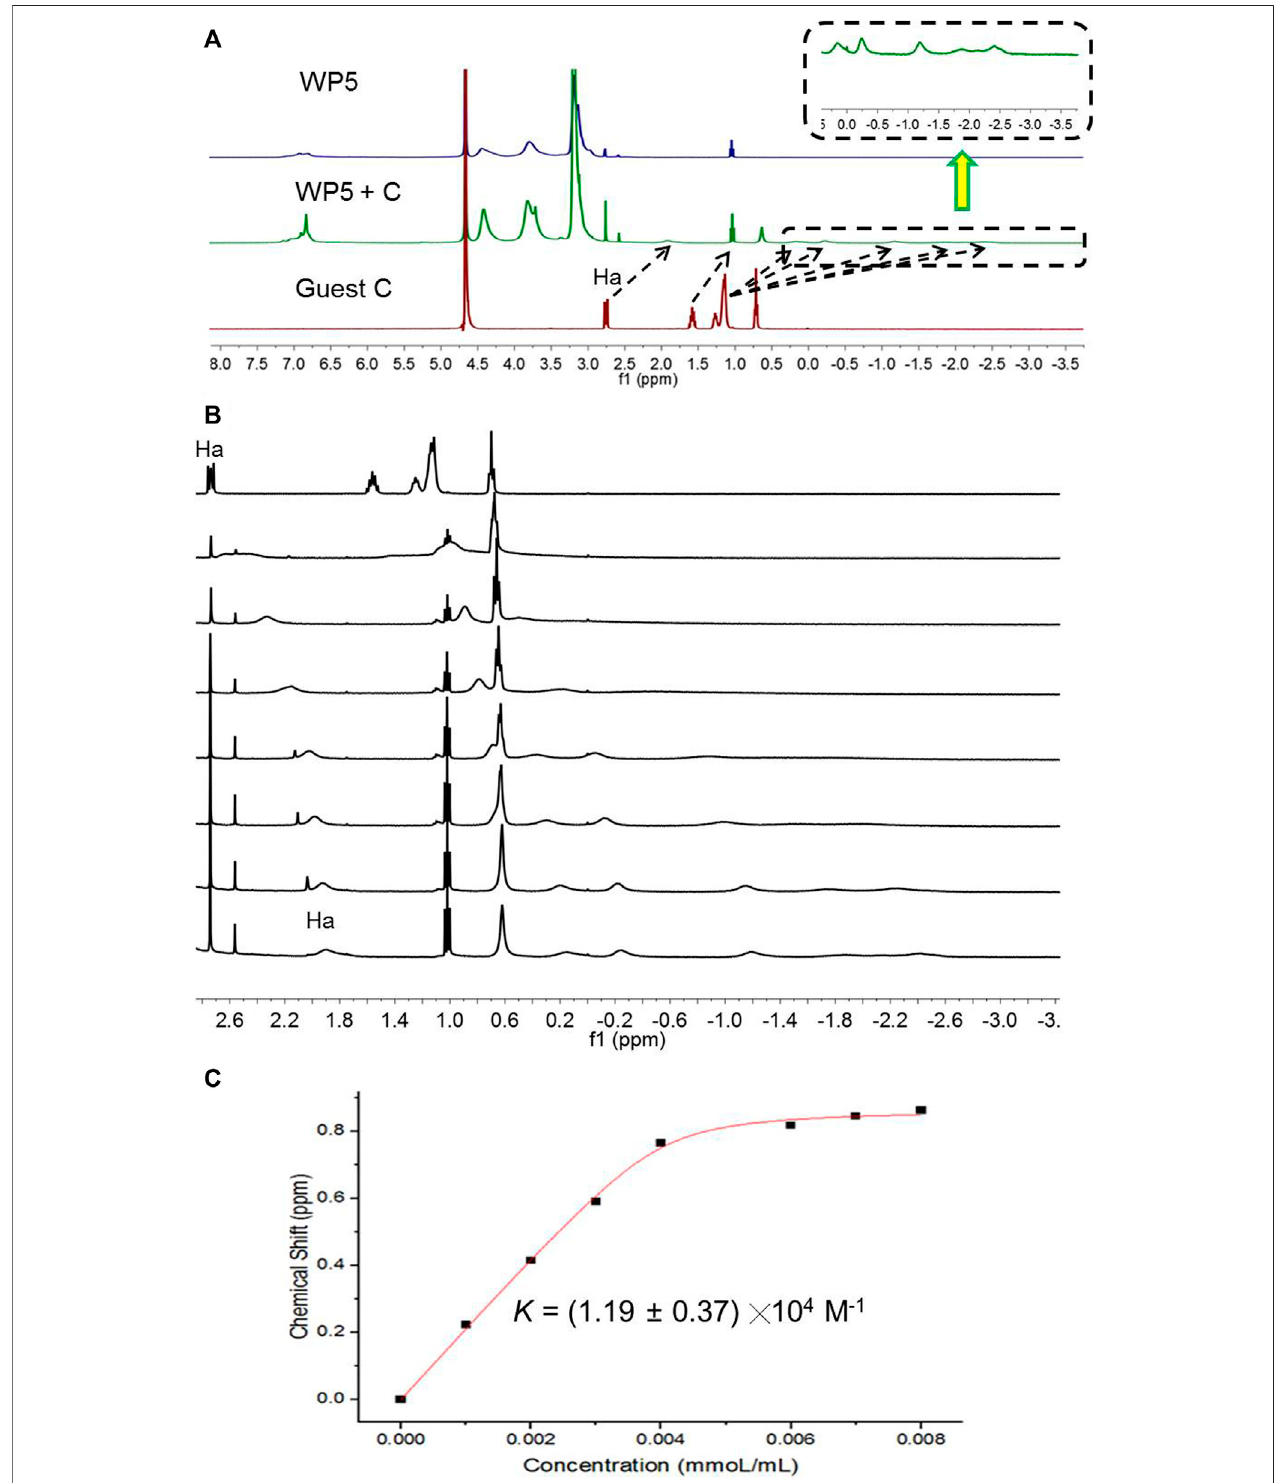
FIGURE1|(A) 1 HNMRspectra(D 2 O,293 K,400 MHz)ofWP5(16.00 mM), (B) WP5 (16.00 mM)+C(16.00 mM),and C(16.00 mM). (C) 1 HNMRspectra(D 2 O, 293 K, 400 MHz) of C at a concentration of 16 mM with different concentrations (mM) of WP5. (C) The chemical shift changes of Ha on C upon addition of WP5.